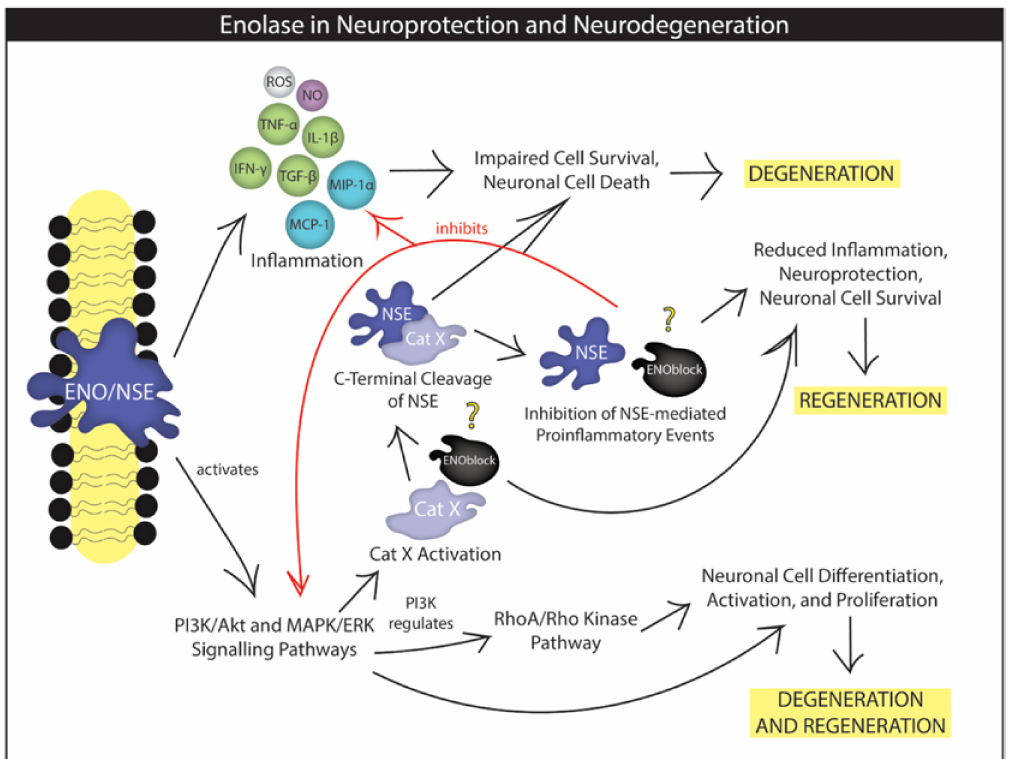
Figure 1. Elevation of enolase promotes glycolysis, cellular proliferation, activation and migration via the PI3K/AKT and MAPK/ERK pathways. Enolase-mediated activation of PI3K also regulates RhoA kinase, which influences actin cytoskeleton reorganization, induction of neurite outgrowth, and growth arrest in neuronal cells. NSE is a substrate of Cat X, and regulation of NSE by Cat X may determine neuronal survival during CNS injury. Treatment with enolase inhibitor, ENOblock, may attenuate NSE, Cat X, and other inflammatory events in SCI, thus reducing neuroinflammation and neurodegeneration and promoting neuronal survival and/or